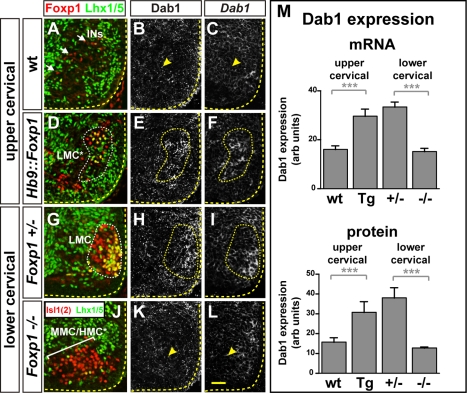
Foxp1 regulates Dab1 expression.(A–L) Dab1 mRNA and protein expression in the cervical spinal cord of e12.5 Hb9::Foxp1 transgenic (D–F), Foxp1 mutant (J–L), and control embryos (A–C, G–I). (M) Dab1 mRNA and protein mean pixel intensity measurement within Foxp1+ Lhx3− LMC regions (fine stippled outline; D–F, G–I) or the corresponding Foxp1− Lhx3− region (arrowheads; B–C, K–L). arb: arbitrary units on a 0 (no signal) to 255 (maximum intensity) scale. Student's t test p values for mRNA quntifications: Hb9::Foxp1 versus wt, p = 0.002, n = 3 embryos per genotype analysed; Foxp1
−/− versus Foxp1+/
−, p<0.001, n = 3 embryos per genotype analysed; Student's t test p values for protein quantification: Hb9::Foxp1 versus wt, p<0.001, n = 4 embryos per genotype analysed; Foxp1
−/− versus Foxp1+/
−, p<0.001, n = 3 embryos per genotype analysed. All sections of the same genotypes are consecutive. Arrows: Foxp1+ interneurons (INs); LMC*: ectopic LMC; bracket: expanded MMC/HMC*. Thicker stippled lines outline the spinal gray matter. Scale bar: 50 µm.